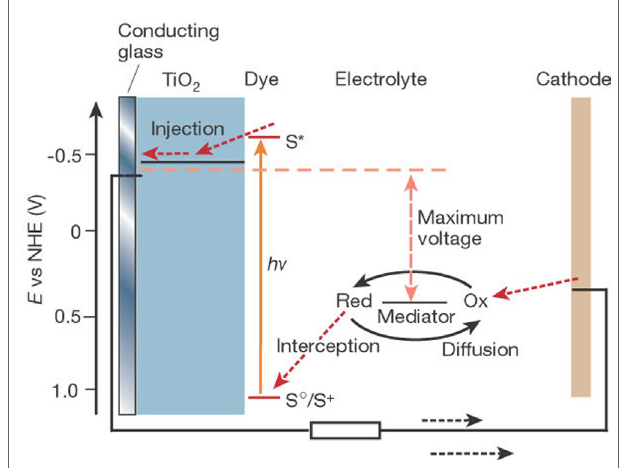
FiGURe 1 | DSSC working principles ( Gratzel, 2001 ) . Copyright Nature Publishing Group,